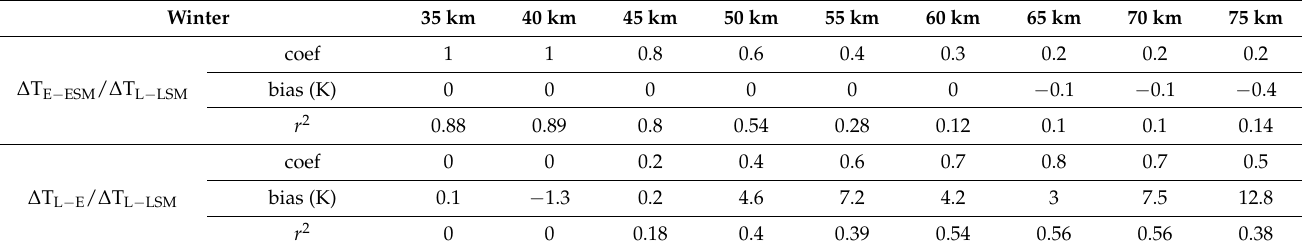
Figure 3. Comparisons of thetemperature differences between ERA-5 and its seasonal mean ( ∆ T E − ESM ) and between the LiDAR and ERA-5 ( ∆ T L − E ) with the temperature differences between the LiDAR and its seasonal mean ( ∆ T L − LSM ) at 40 km ( a , b ) and 70 km ( d , e ) during winter. The correlation between these comparisons was computed with a linear regression (solid red line), and the associated determination coefficient ( r 2 ) is displayed. A perfect correlation without bias is illustrated by the black dashed line. The temperature differences between the LiDAR and the ECMWF corrected by the linear regression ( ∆ T L − E − y) are shown at 40 km ( c ) and 70 km ( f ). The distributions (blue bars) of the temperature differences are added at the top for the x-axis and on the right for the y-axis. Table 1. Numerical values of the slope coefficients at different altitudes for the winter season between the ERA-5 fluctuations ( ∆ T E − ESM ) and the LiDAR fluctuations ( ∆ T L − LSM ), calculated from their respective seasonal mean, and between the LiDAR and model temperature differences ( ∆ T L − E ) and the LiDAR fluctuations ( ∆ T L − LSM ). Mean biases calculated simultaneously are also provided, as well as the determination coefficient of the regression analysis ( r 2